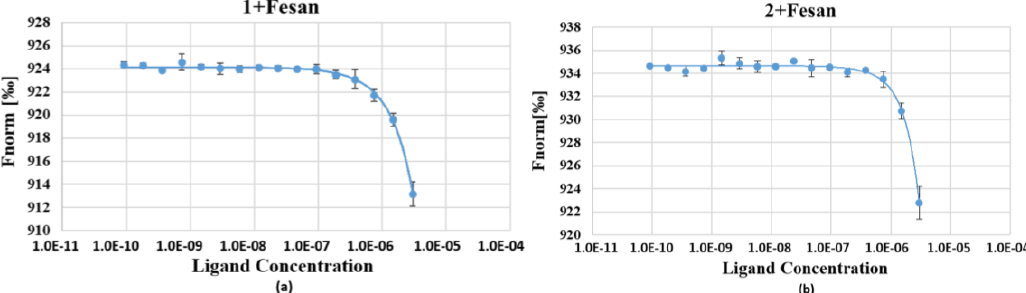
Figure 10. Curves obtained from microscale thermophoresis experiments aimed at assessing the affinity of ferra(III) bis(dicarbollide) (FESAN) for fluorescently labeled oligonucleotides FL-1 ( a ) or FL-2 ( b ). The oligonucleotide samples were titrated with ferra(III) bis(dicarbollide) at concentrations ranging from 182 pM to 3000 nM. The experiments were run at 22 °C. The ligand concentration is given in M.